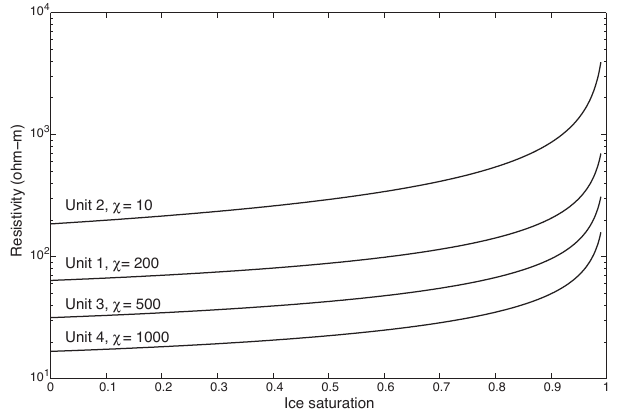
Figure 2. Bulk resistivity as a function of ice saturation using the physical properties defined for each of the lithologic units described in Table